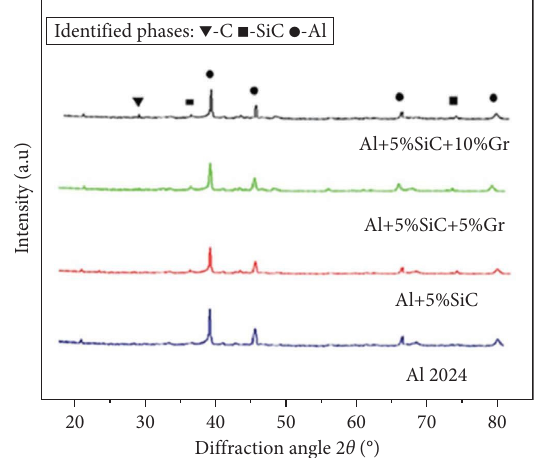
8: XRD analysis of Al/SiC/Gr and HAMCs products with various compositions, reproduced with permission from Ref. [72, 75], copyright 2013,